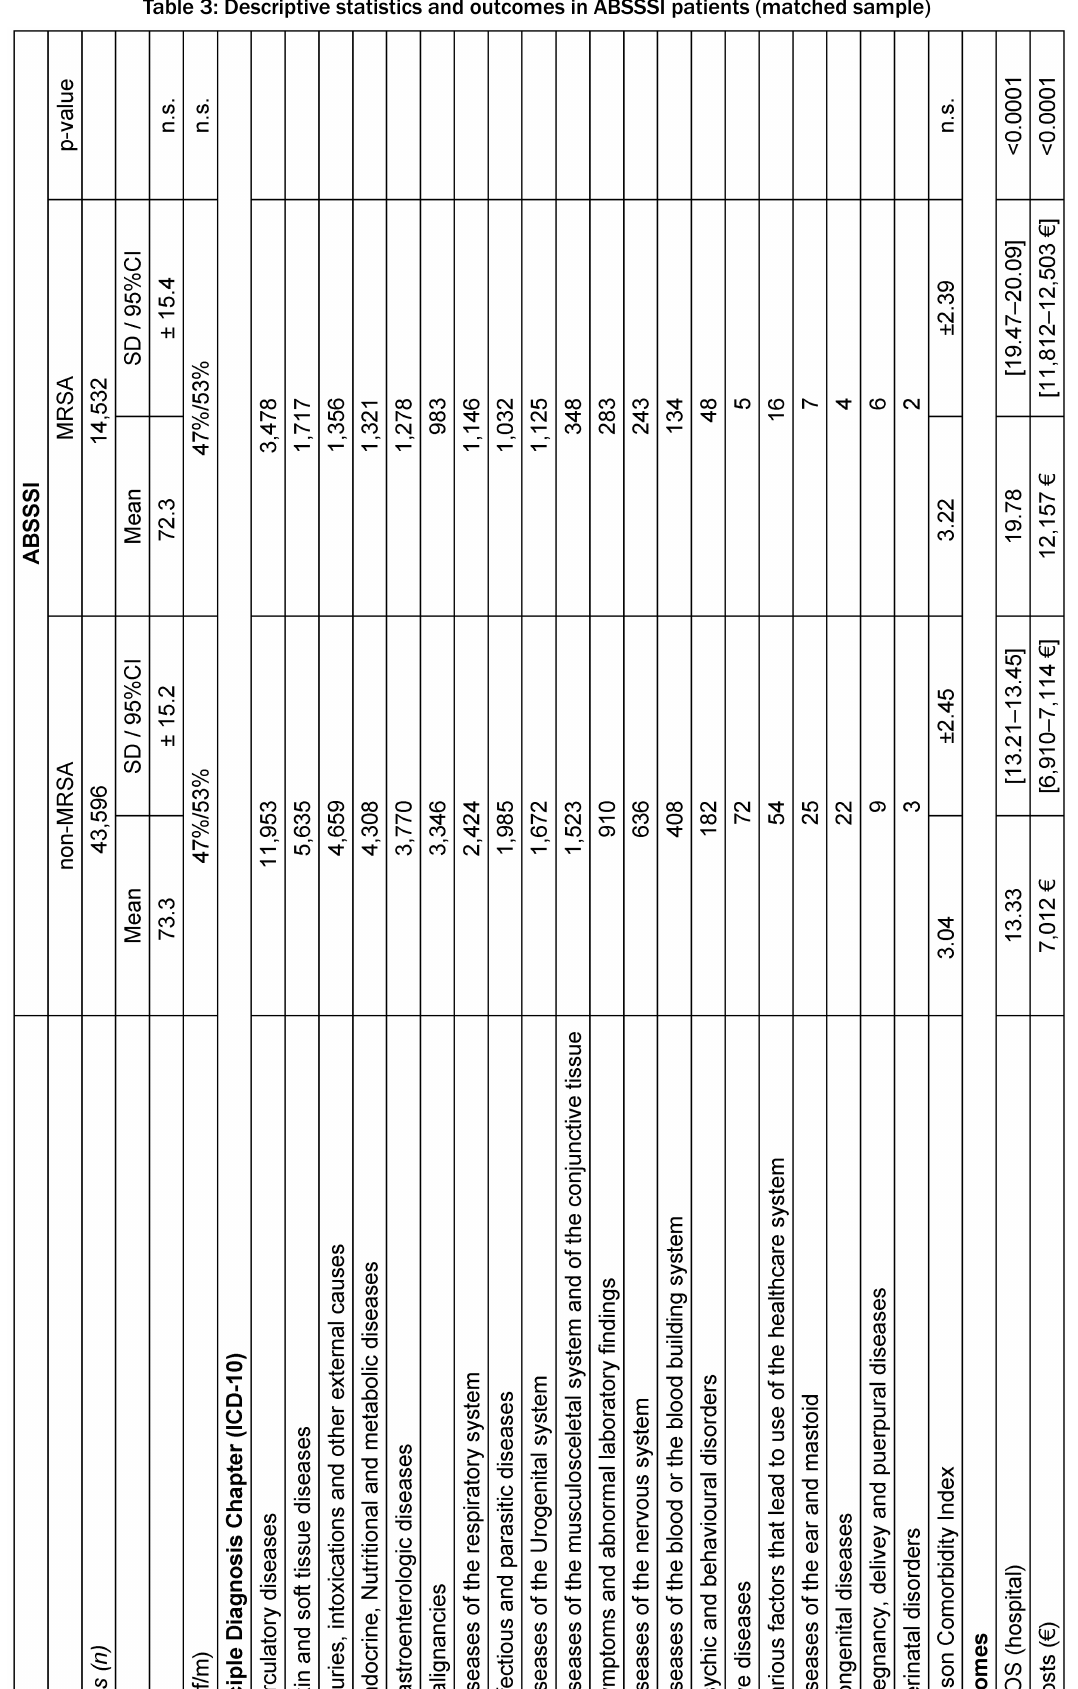
Table 3: Descriptive statistics and outcomes in ABSSSI patients (matched